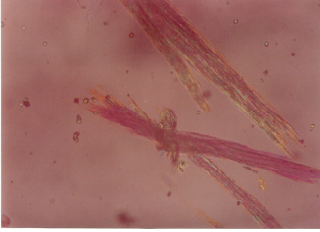
SO [2.5 M], 2 4 SO [1M], 2 4